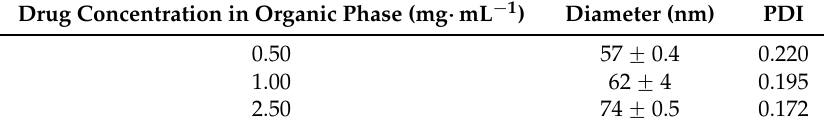
Table 4. The mean diameter of micelles produced using membrane device as a function of drug concentration in the organic phase. The organic phase was 1 mg ¨ mL ´ 1 PEG- b -PCL (B) in acetone with designated drug content.